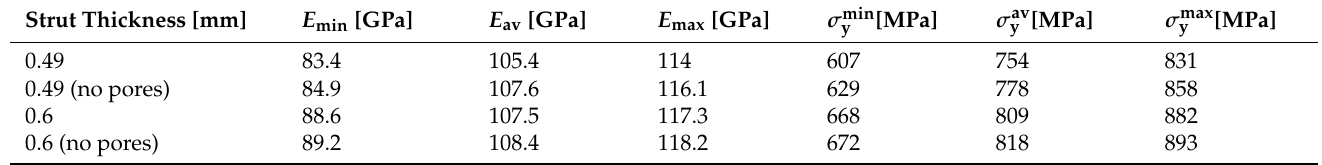
Table 1. Minimum, average, and maximum nominal values of Young’s modulus and yield stress.